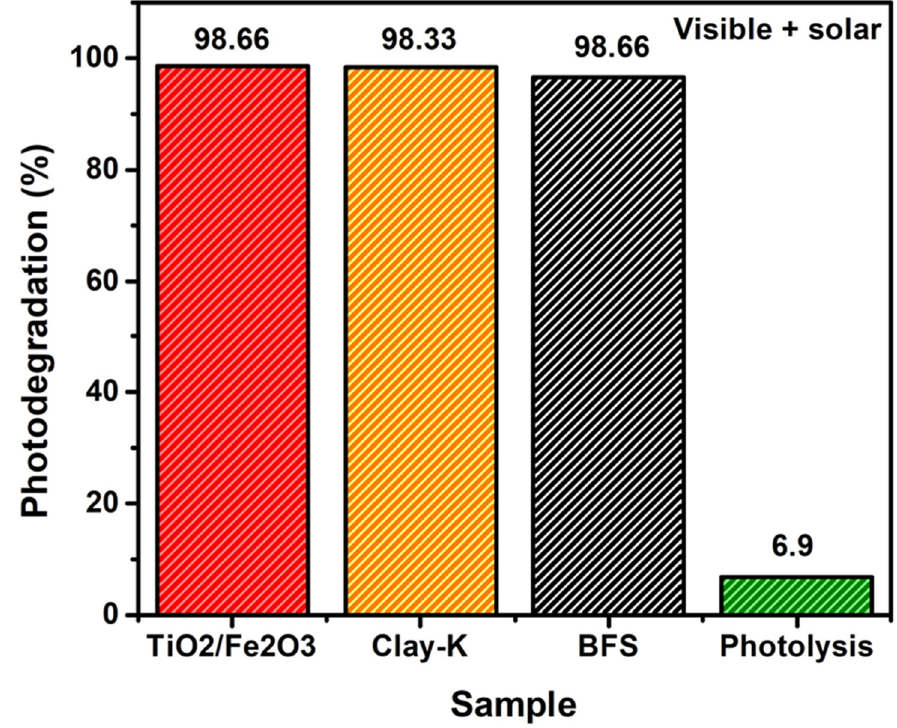
Figure 13. Percentages of cyanide photodegradation with Clay-K, BFS, and Fe 2 O 3 /TiO 2 materials using visible and solar irradiation for 2 h. Initial concentration of NaCN of 750 mg/L.